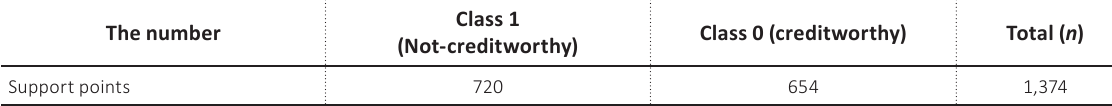
Table A8. Number of support vectors